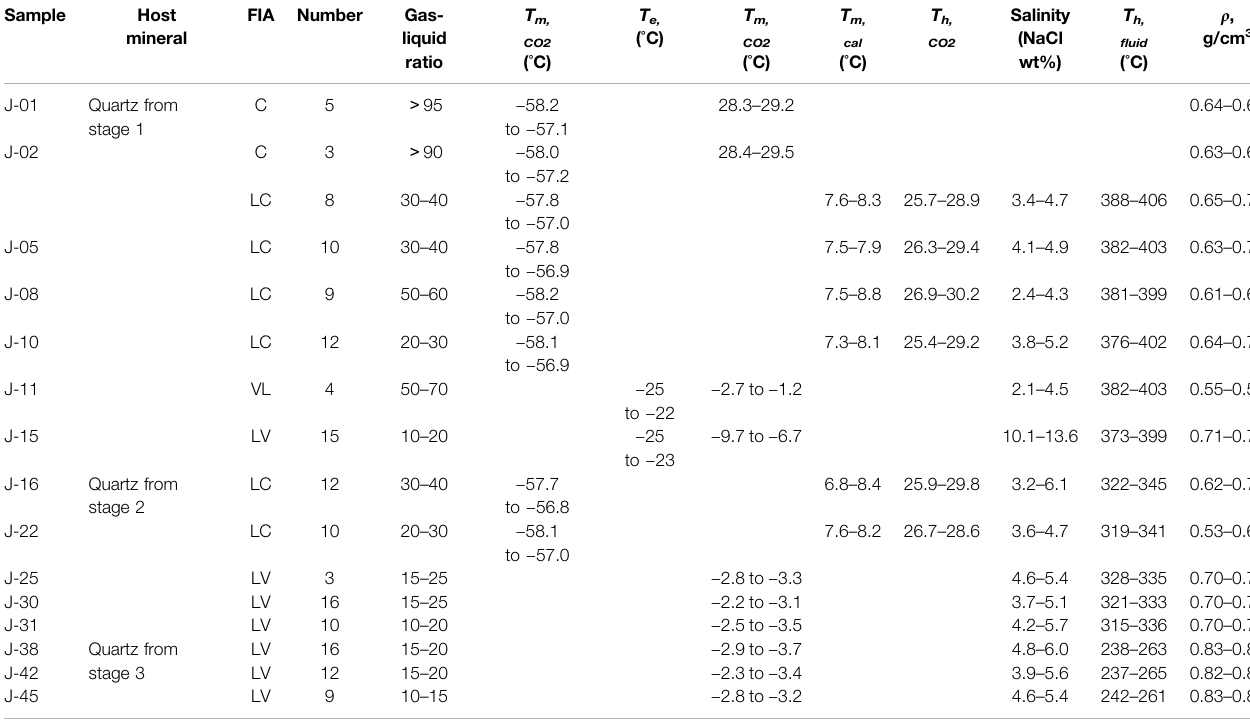
TABLE 2 | Microthermometric data from FIs in hydrothermal quartz of the Jinba gold deposit.